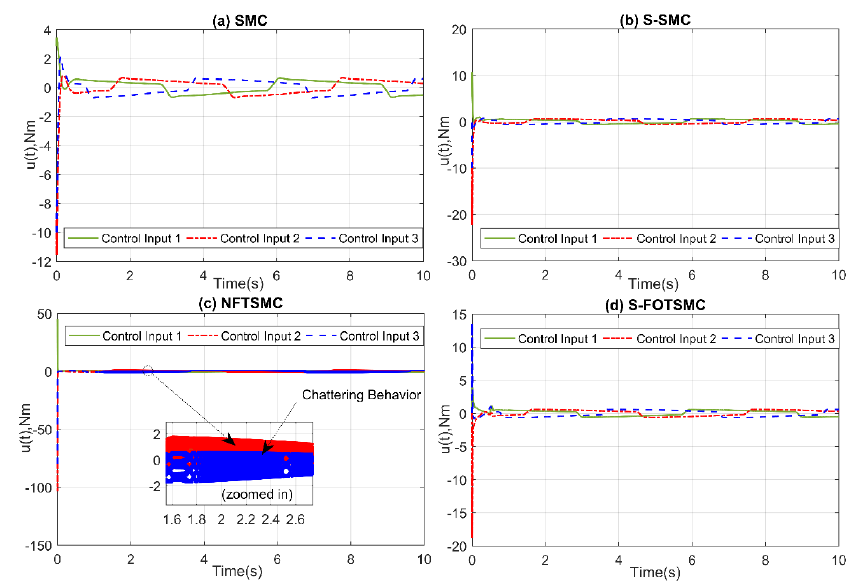
Figure 8. The control input signals: ( a ) SMC, ( b ) S-SMC, ( c ) NFTSMC, and ( d ) S-FOTSMC. Case 2. When the parallel manipulator tracks a linear trajectory.